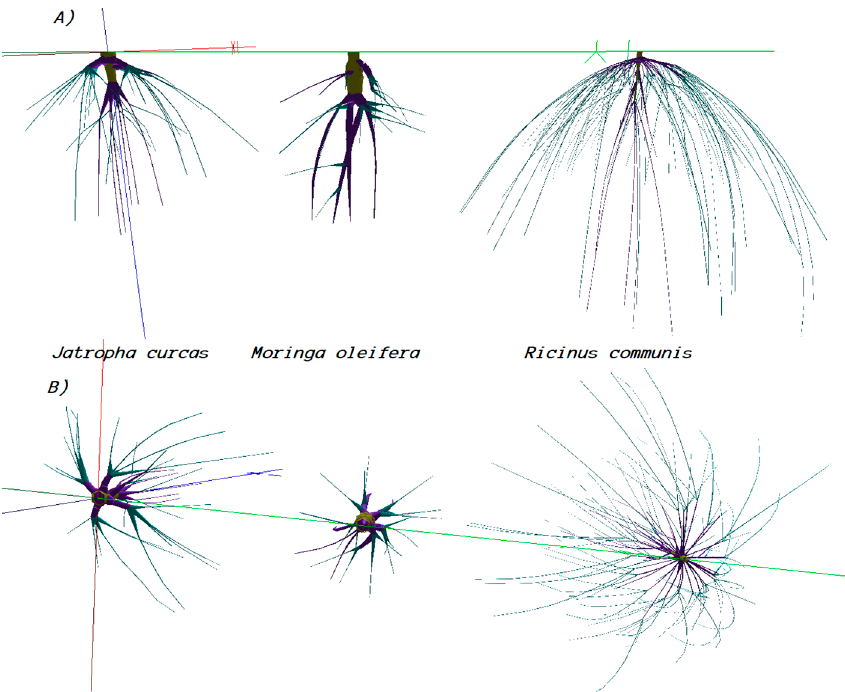
Figure 4. Roots of Jatropha , Moringa , and Ricinus digitized 83 days after their root pruning and transplant. A ) Vertical projection; B ) Horizontal projection.